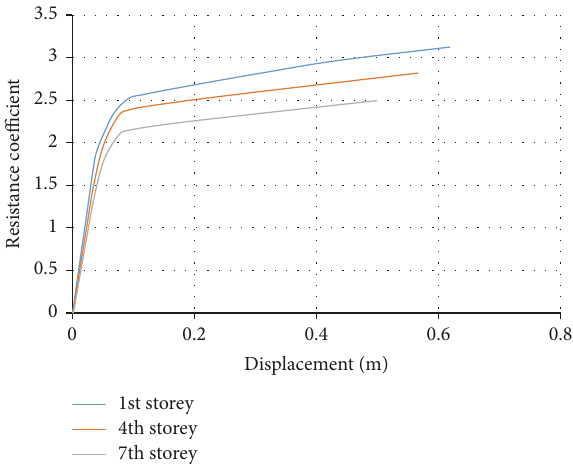
Figure 23: Vertical displacement-resistance coefficient curves obtained by removing the middle column in different floors.